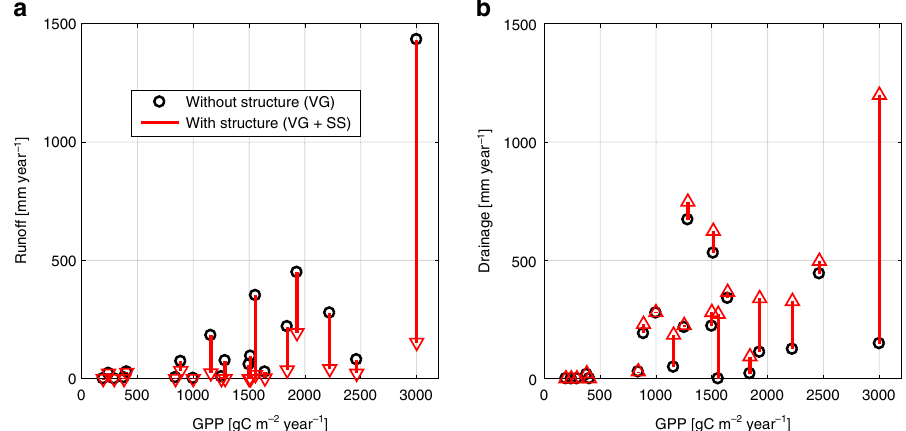
Fig. 3 Local-scale effects in runoff and drainage. Simulated long-term average (T&C) ecosystem-scale runoff ( a ) and water drainage at the bottom of the soil pro fi le ( b ) for the 20 locations as a function of the local Gross Primary Production (GPP). Two scenarios are shown: VG soil hydraulic parameter (van Genuchten parameterization) derived from global maps and without soil structural effects and VG + SS soil hydraulic parameter derived from global map with soil structural effects. The red arrows indicate the magnitude of change after introducing soil structural